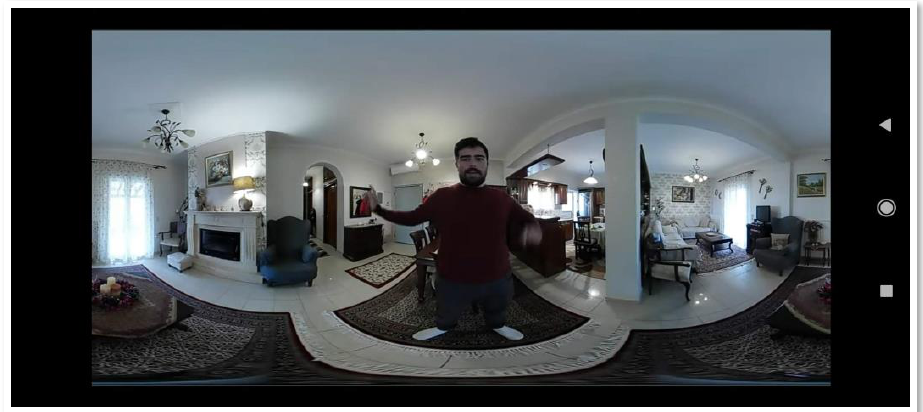
Figure 16. Production phase: while shooting.